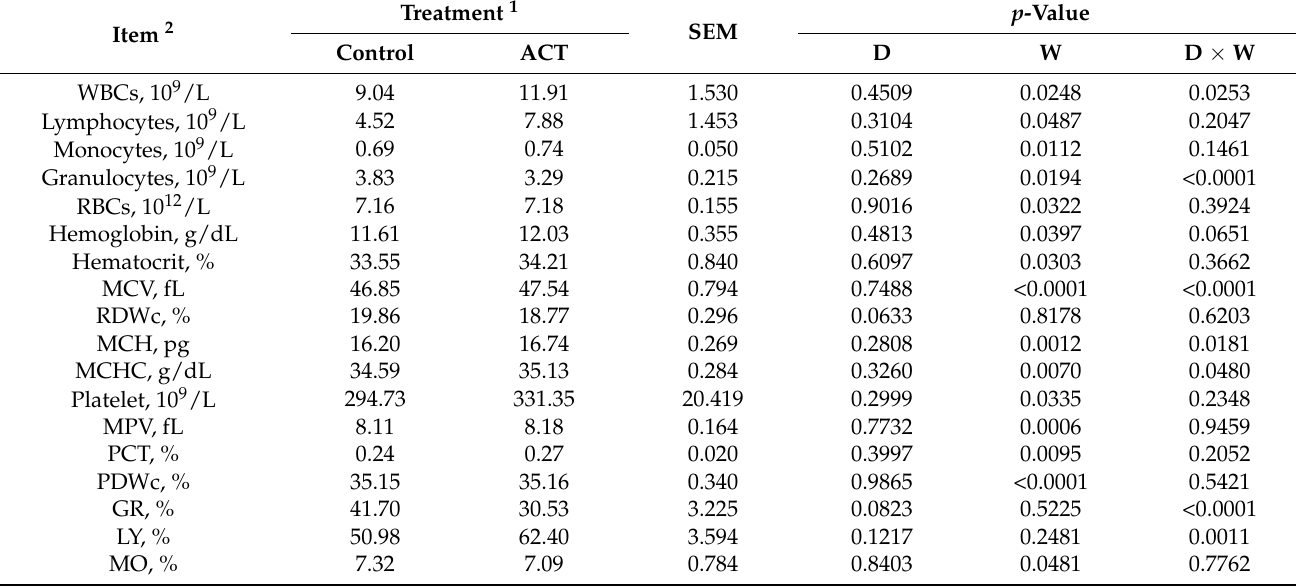
Table 6. Complete blood count analysis of cows